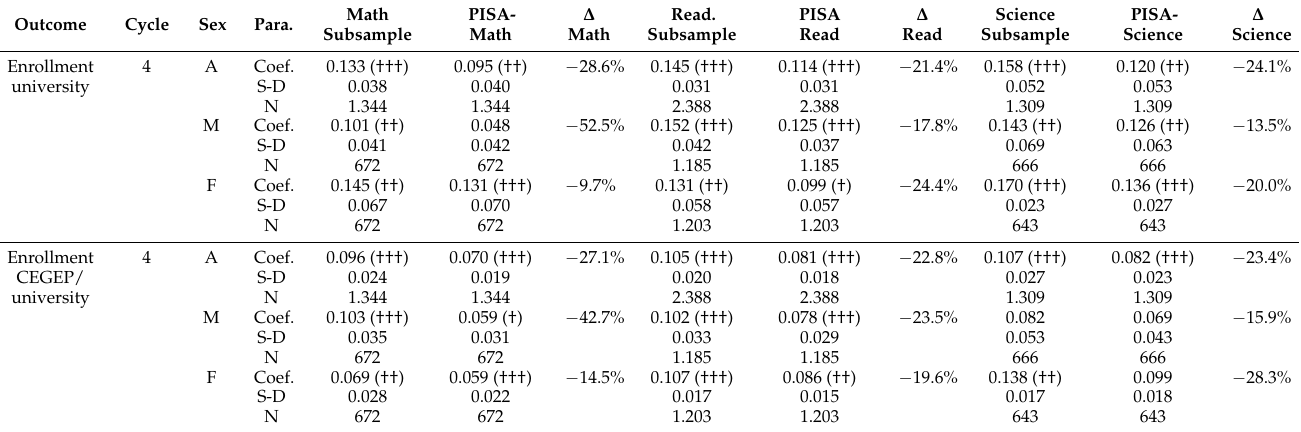
Table 7. Estimated effects of independent high school on academic outcomes by sex and PISA scores as additional matching covariate, cohort A cycle